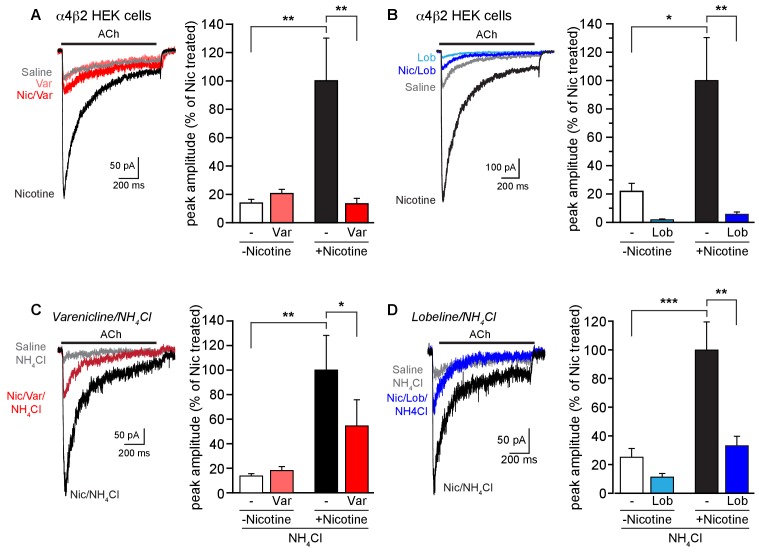
Effect of smoking cessation reagents on functional upregulation.(A) In this and other recordings, a 17–20 hr treatment with nicotine (Nic, 10 μM) induced a robust, ~5 fold, increase in peak current amplitudes evoked by 1 mM ACh from α4β2R-expressing HEK cells. Varenicline (Var, 30 μM) treatment for an equivalent time had no effect on ACh-evoked peak current amplitudes alone but prevented upregulation of nAChR function when co-incubated with nicotine. Traces represent currents evoked by ACh in cells that were untreated or treated for 17 hr with vehicle, nicotine, varenicline, or with varenicline and nicotine. The number of recordings were 16, 18, 18, and 17, respectively. (B) Chronic lobeline (Lob, 30 μM) exposure reduced the peak ACh current amplitude relative to control and prevent nicotine upregulation. Traces represent currents evoked by ACh in cells that were untreated or treated for 17 hr with vehicle, nicotine, lobeline, or with lobeline and nicotine. The number of recordings were 13, 18, 13, and 15, respectively. (C) NH4Cl treatment (two 10 min washes) partially reverses the suppressive effects of varenicline on nicotine-induced functional upregulation. Traces show representative currents evoked by ACh from cells pretreated for 17–20 hr with vehicle, nicotine, or nicotine and varenicline before exposure to NH4Cl. The varenicline-alone condition is omitted for clarity. The graph is as in (A) except that the cells were treated with NH4Cl as noted. The profound reduction in nicotine-induced upregulation caused by varenicline co-incubation was lessened following treatment with NH4Cl. The number of recordings were 21, 22, 25, and 25, respectively. (D) Traces show representative currents evoked by ACh from cells pretreated for 17–20 hr with vehicle, nicotine, or nicotine and lobeline before exposure to NH4Cl. In this dataset, lobeline-induced suppression of nicotine upregulation was modestly attenuated by treatment with NH4Cl. The number of recordings were 14, 15, 16, and 19, respectively. In all the column graphs: * p<0.05; **p<0.01; ***p<0.001 by one-way ANOVA with Tukey’s multiple comparison test. Columns show group mean and error bars are the s.e.m.